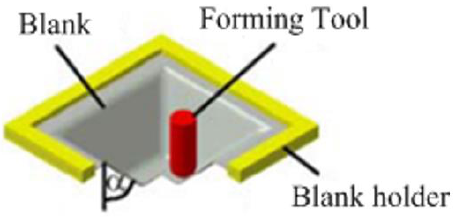
Figure 5. Single-point incremental forming (adapted with permission from Ref. [48], 2004, copyright CIRP).